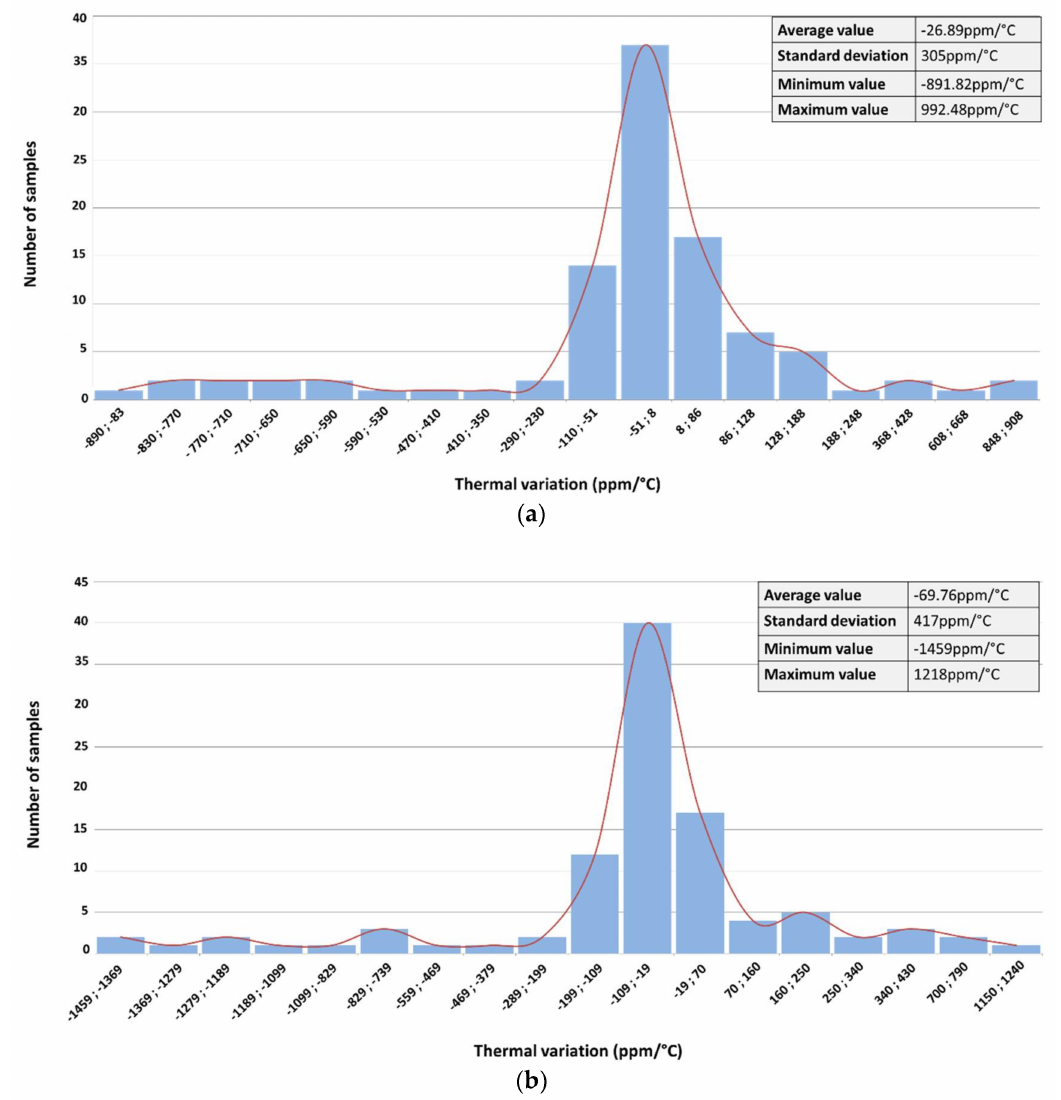
Figure 15. Monte Carlo simulation of the thermal stability of the sensor interface: ( a ) V S = 20 mV; ( b ) V S = 40